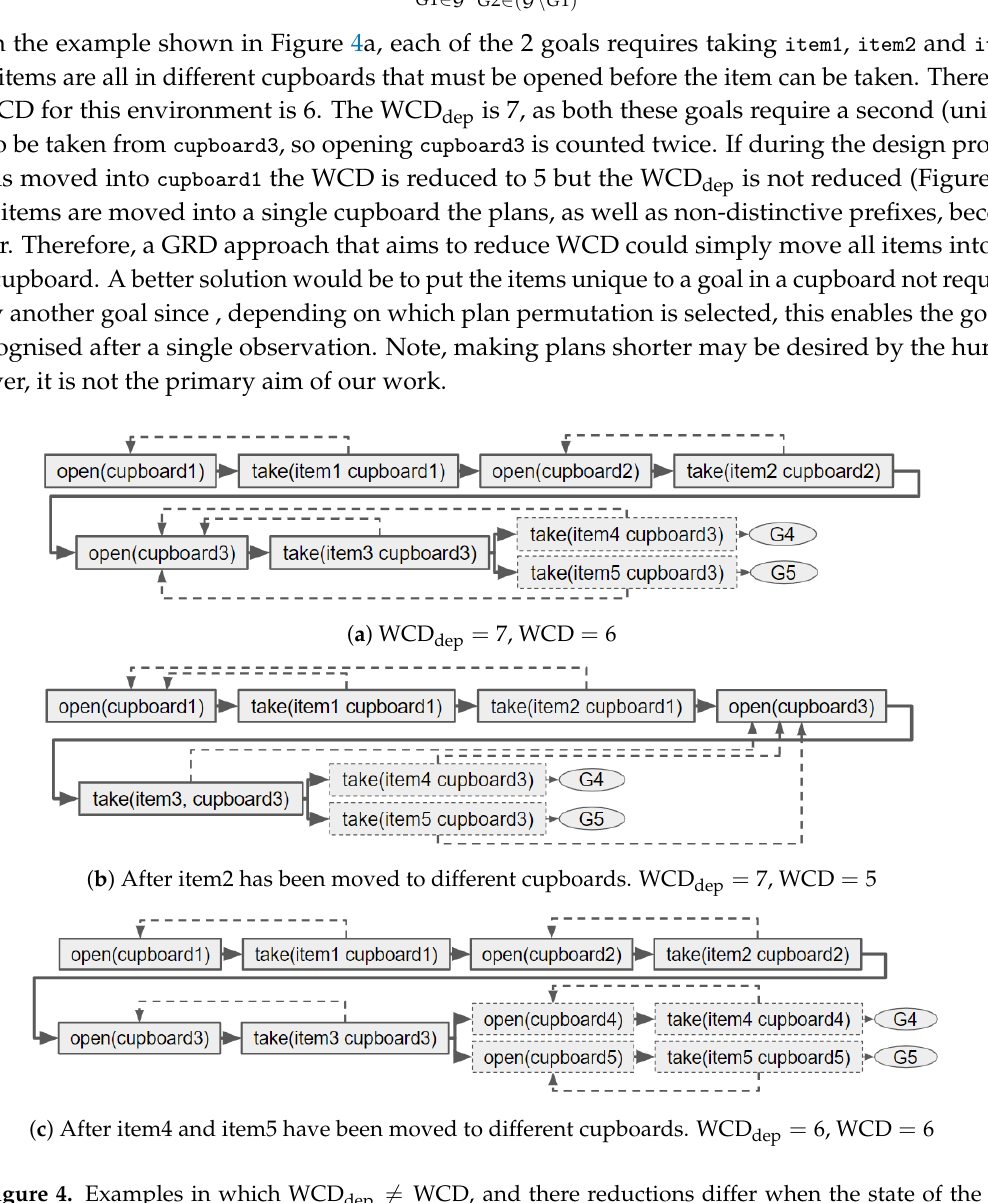
Figure 4. Examples in which WCD dep (cid:54) = WCD, and there reductions differ when the state of the environment is changed. A single plan permutation is provided. The dashed arrows go from dependant to